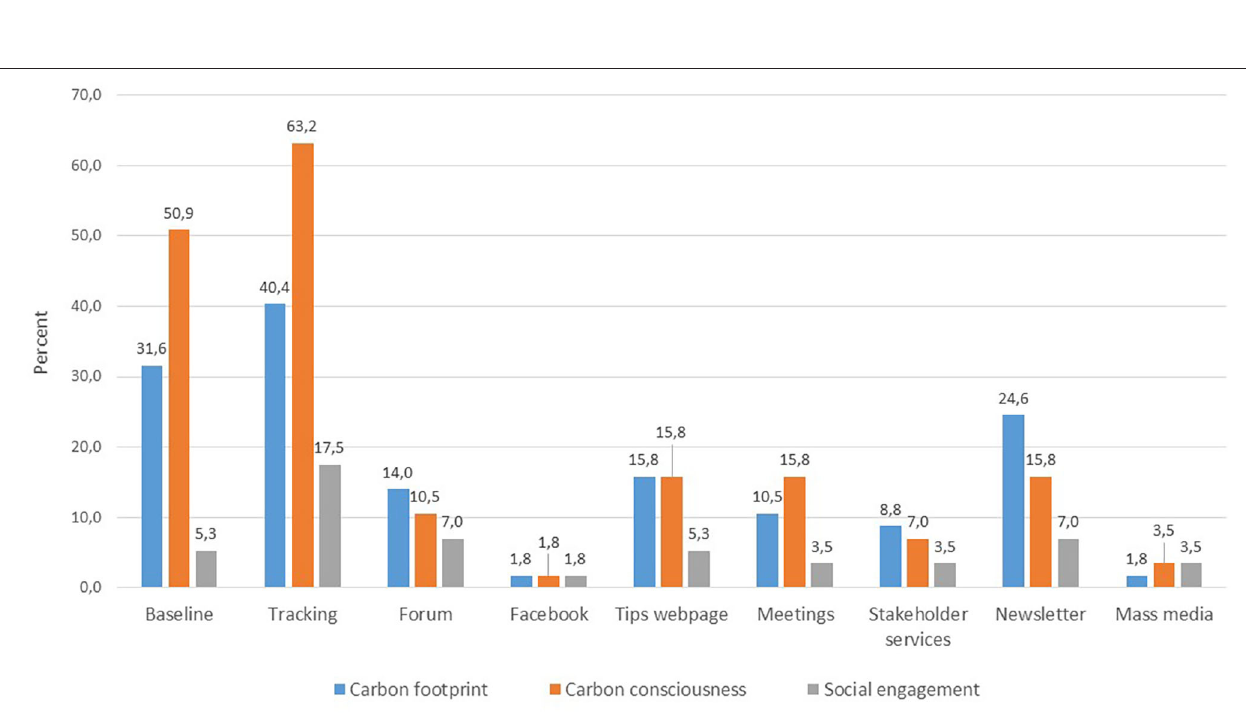
Frontiers in Sustainability |